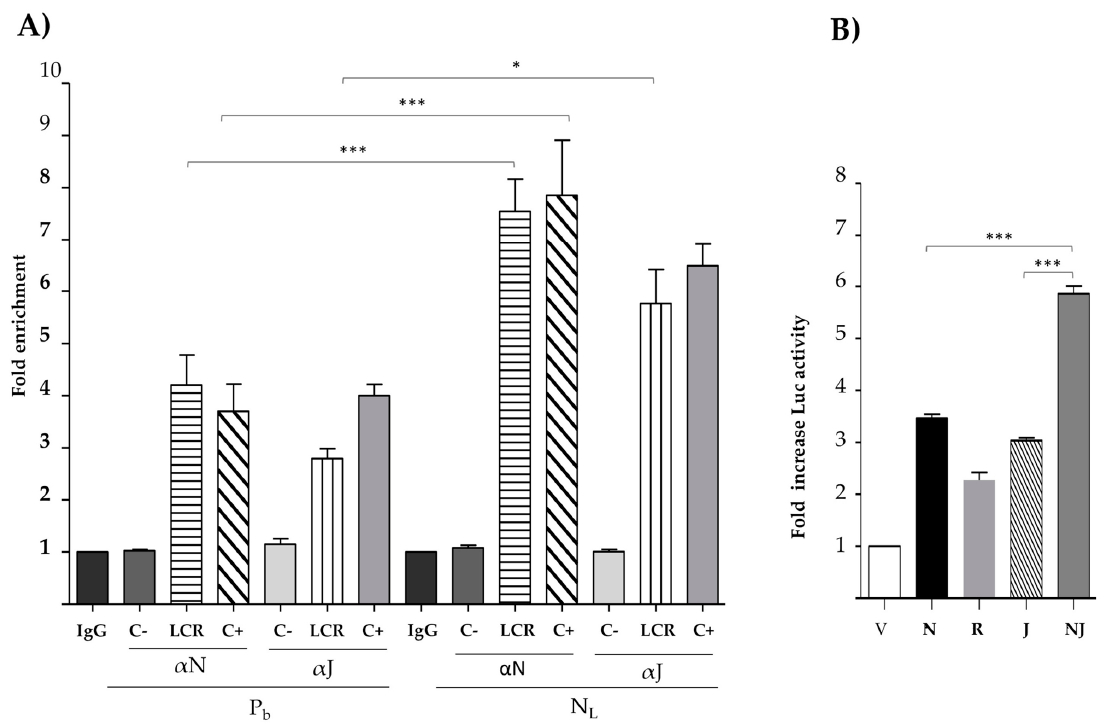
Figure 4. Nanog and c-Jun cooperate to increase LCR activity. ( A ) Chromatin immunoprecipitation assay (ChIP) was per- formed on HeLa cells treated with vehicle (P b ), left, or cells transduced with lentivirus expressing Nanog and collected seven days after (N L ), right. Chromatin was immunoprecipitated with anti Nanog ( α N) and anti c-Jun ( α J) antibodies. Anti IgG antibody was used as isotype negative control (IgG). qRT-PCR was performed with primers for the HPV18 LCR to measure Nanog and c-Jun binding (LCR) and a region of chromosome 7, as a negative control (C-) for both Nanog and c- Jun. Nanog promoter and cyclin D1 promoter (C+) were used as positive controls for Nanog and c-Jun, respectively. ( B ) TC-1 cells were transiently transfected with vectors containing the HPV18 LCR (LCR 18), driving the expression of the luciferase gene, and co-transfected with empty vector (V), Nanog (N), H-Ras V12 (R), and c-Jun (J) alone or in combination with N (NJ). The luciferase reporter activity was measured 48 h post-transfection. The standard error of the mean of three independent experiments, in triplicate, is depicted in the graph. One-way ANOVA test with a Tukey analysis was per- formed to assess the significant differences. * p <0.05, *** p ≤ 0.001. To determine whether Nanog and c-Jun together are able to increase the activity of HPV18 LCR more than N or J separately, we performed a luciferase assay. TC-1 cells were transfected with the HPV18 LCR and co-transfected with V, N, R, J, or N and J together (NJ). We observed a 5.9-fold increase in luciferase activity in the condition where NJ was co-transfected, compared with N alone (3.5-fold) or J alone (3.0-fold) (Figure 4B). There- fore, the combined effect of Nanog and c-Jun is stronger than either of these factors alone. 3.5. Identification of Nanog-Binding Sites in LCRs of Different Alpha- and Betapapillomaviruses Associated with Cancer Development In order to evaluate if Nanog-binding sites shown here to activate transcription of E6/E7 are found in the regulatory regions of other viral types, we analyze LCR sequences from several HPVs. In addition, we performed a comparative analysis of the putative- binding sites in HPV associated or not with cancer development. We performed an in- silico analysis of LCR sequences from different HPV types, searching for putative Nanog- binding sites that could contain elements related to sequences previously described (43,45).